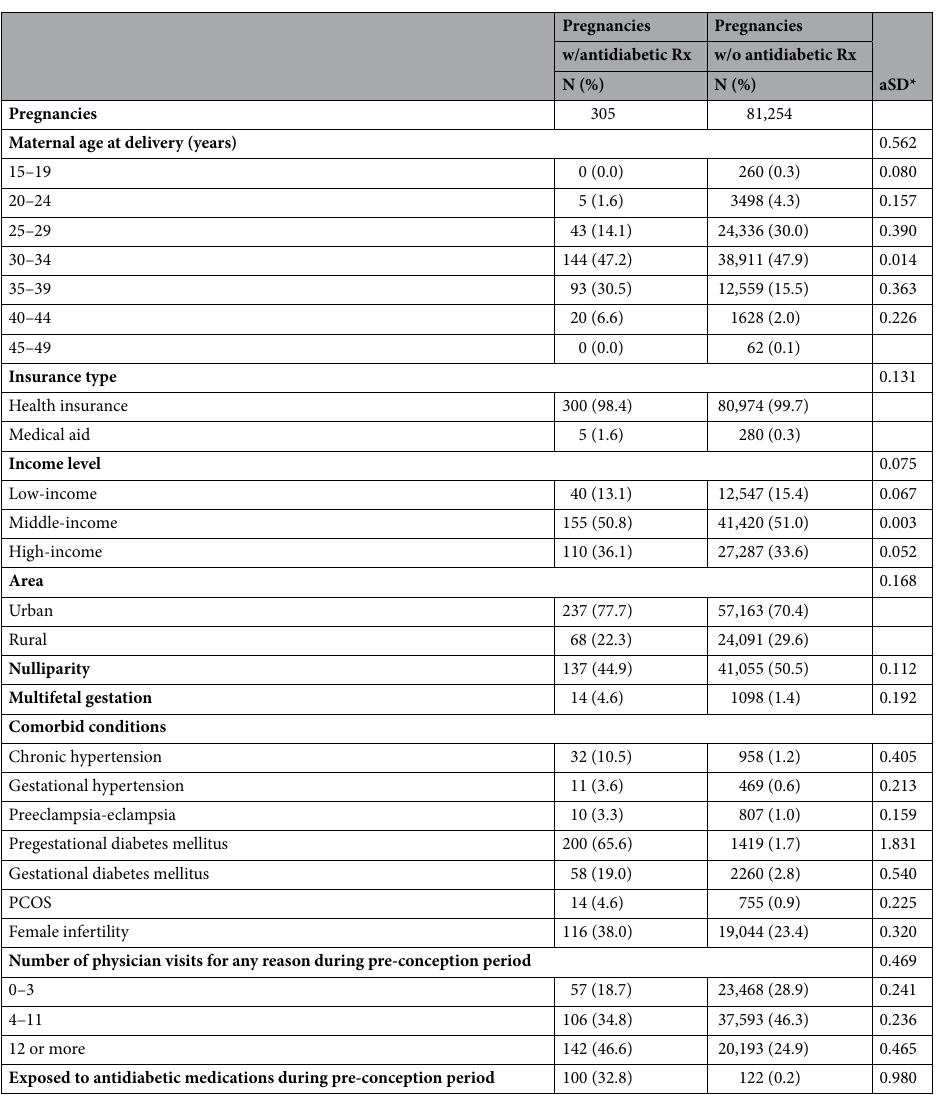
Table 1. Comparison of characteristics between pregnancies with and without antidiabetic prescriptions during pregnancy, 2004–2013 (total pregnancies = 81,559). aSD, absolute standardized difference; Rx, medical prescriptions; PCOS, polycystic ovary syndrome. *Absolute standardized difference, whereby value > 0.10 indicates significant difference between antidiabetic medication users and non-users during